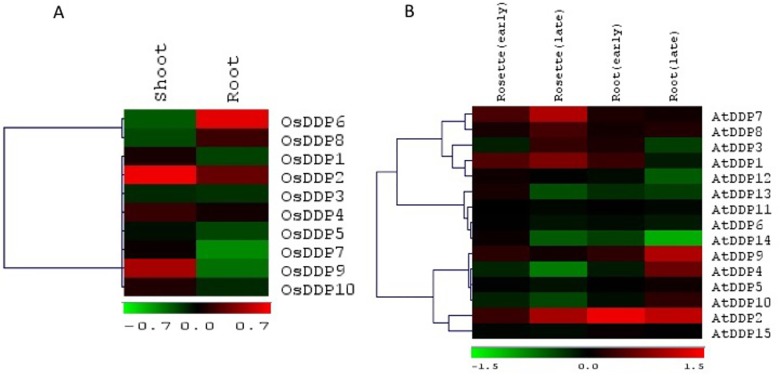
Microarray-based expression pattern of DDP genes under salinity stress.Expression analyses of DDP genes of rice (A) and Arabidopsis (B) under salt stress in shoots and roots as indicated above the heat map. Weighted average linkage method and Pearson correlation distance metric were used for hierarchical clustering of DDP genes. The color bar below the heat maps represent relative expression values with green color representing the lowest expression while as, red the highest expression level.